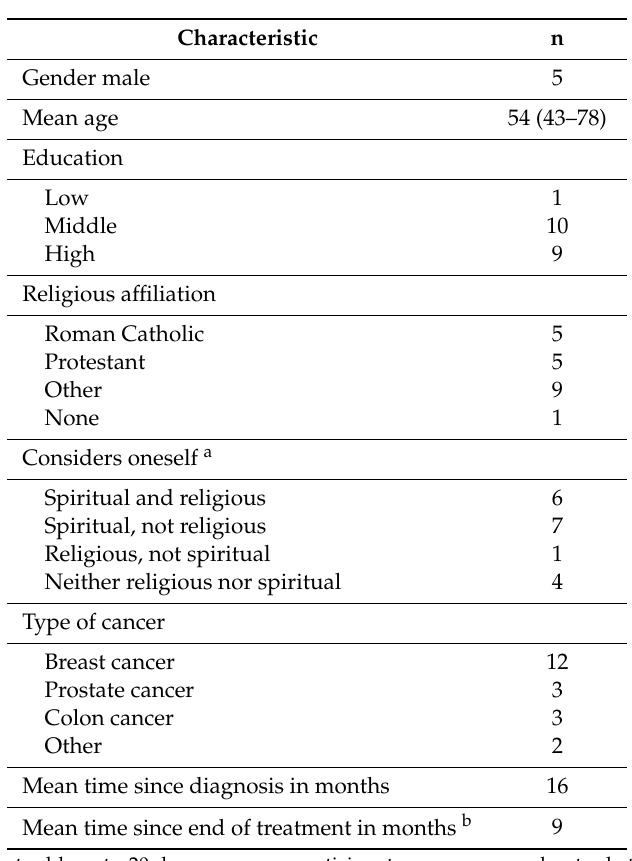
Table 1. Sociodemographic and medical characteristics of the study participants (n =